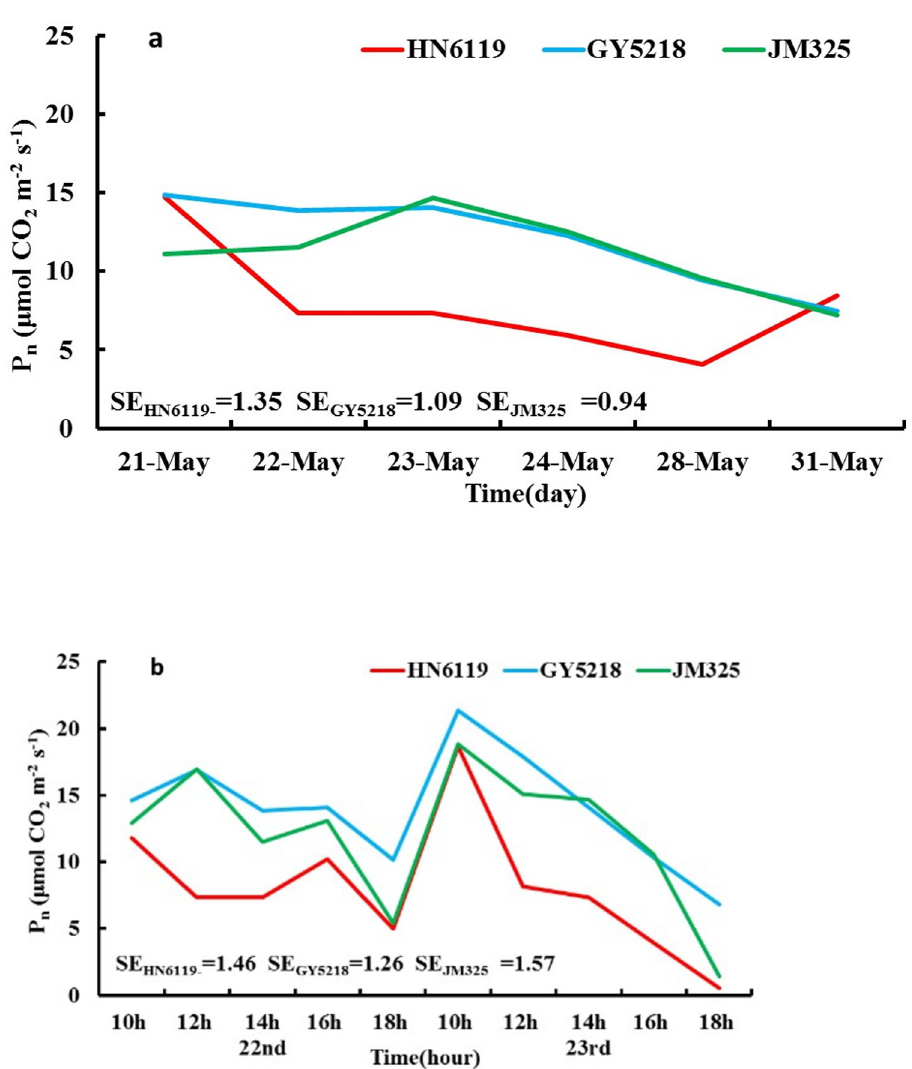
Fig 1. (a) Change curves of P n (unit: μ mol CO 2 m -2 s -1 ) for the three cultivars affected by DHW from May 21 st to 24 th and on May 28 th and May 31 st , 2019; (b) the daily change curves of P n (unit: μ mol CO 2 m -2 s -1 ) for the three cultivars affected by DHW from May 22 nd to 23 rd , 2019. (SE is the abbreviation of the standard error of P n . The red, blue, and green lines denote the wheat cultivars for HN6119, GY5218, and JM 325,